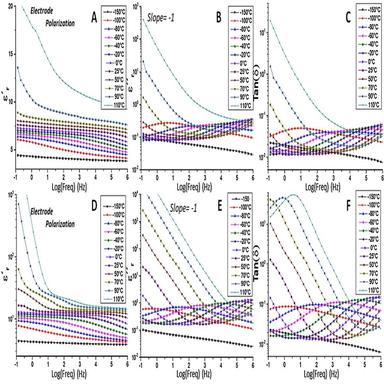
Evolution of ε′, ε″ and tan δ with frequency at different temperatures, for PCNMeiT (A, B, C) and PDCNiT (D, E, F).